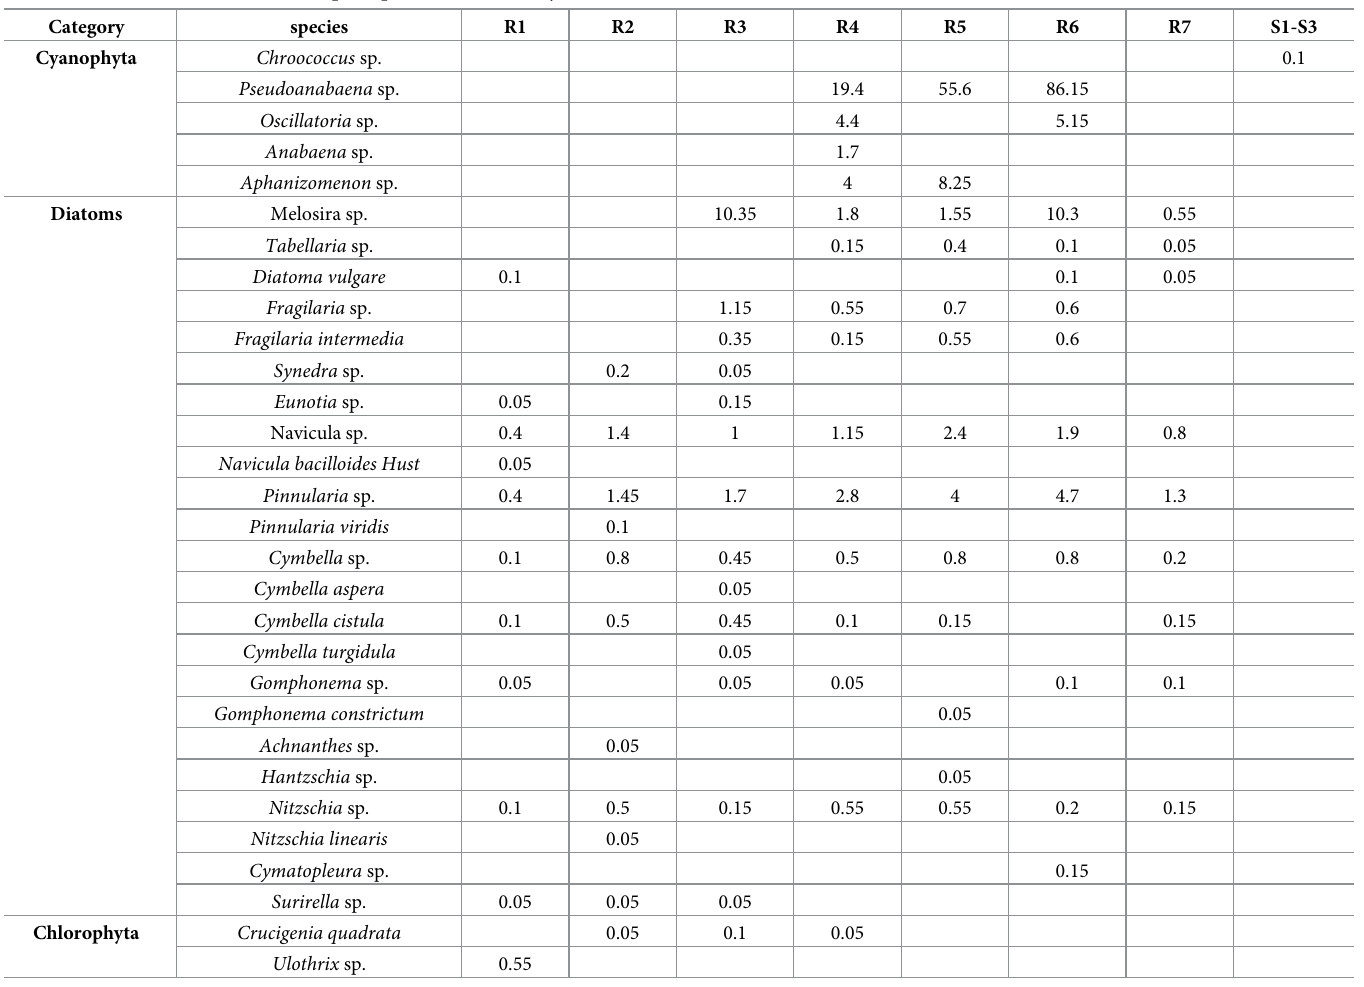
Table 8. Distribution characteristics of photoplankton in the study area ( × 10 4 cell/L). Category